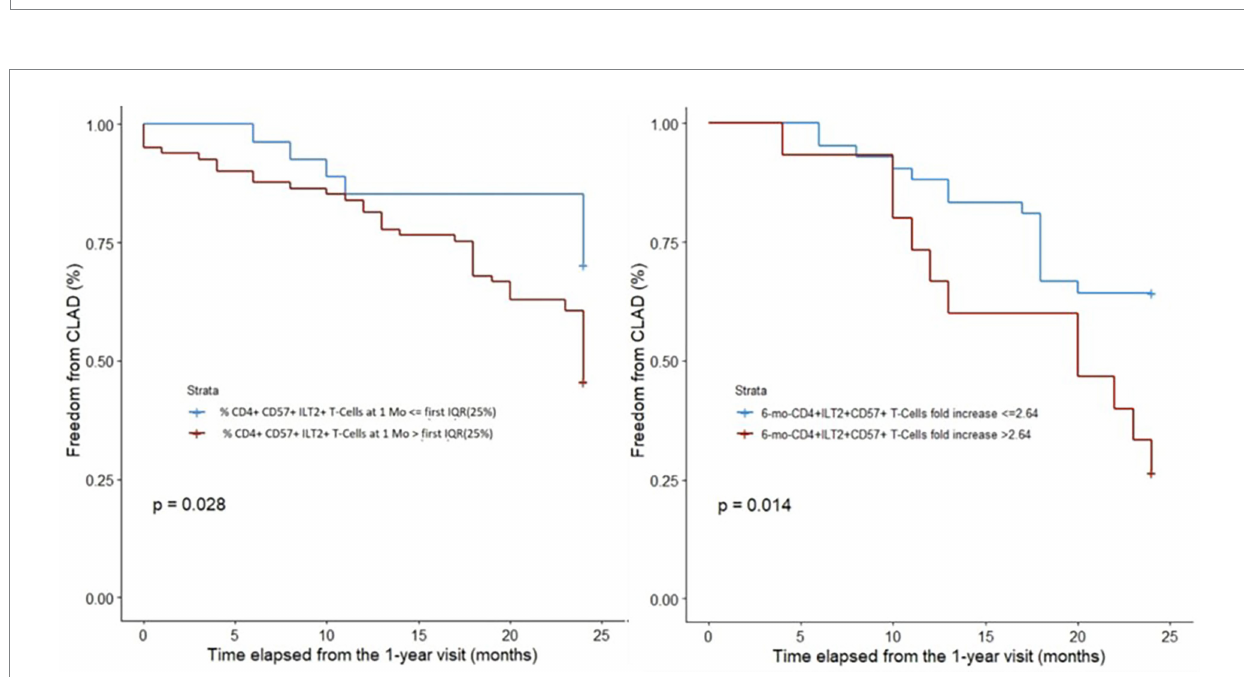
FIGURE 12 ROC curve and Kaplan–Meier analysis of the level of CD9 + B cells 24 months post-LT in BOS and STA patients of the validation cohort, adapted from